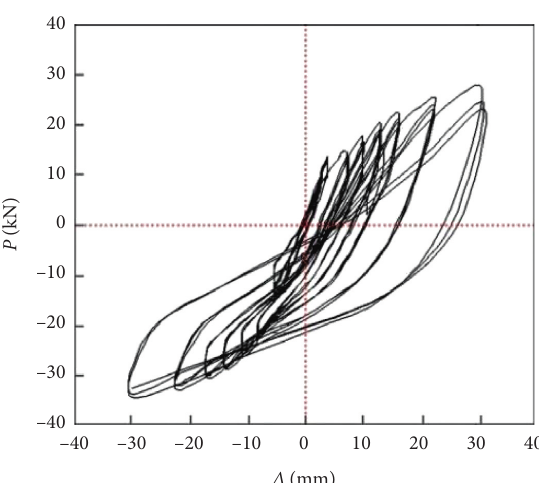
Figure 6: Hysteretic curves of the specimen.